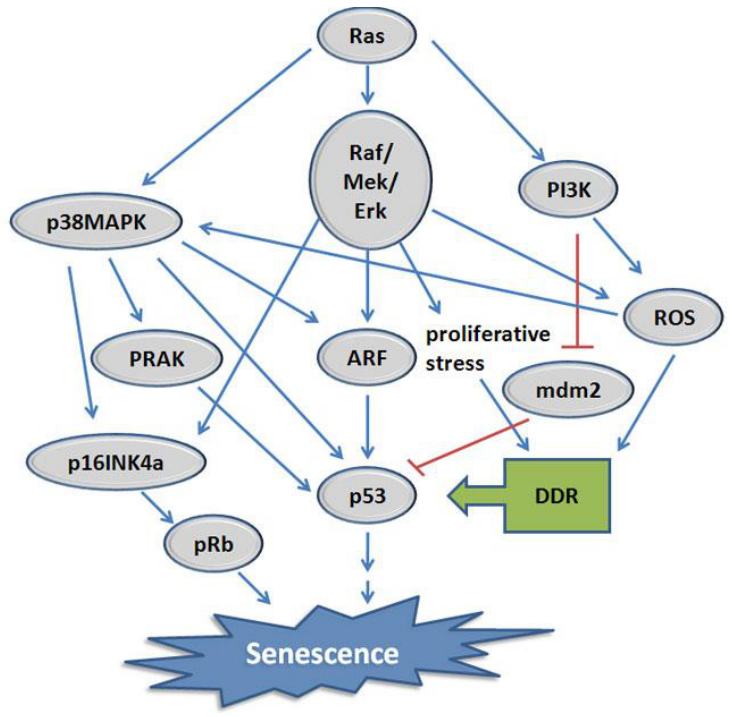
FIGURE 3. Schematic diagram of Ras pathway activation leading to senescence. Ras can activate the Raf/Mek/Erk pathway, PI3K pathway, and p38MAPK, leading